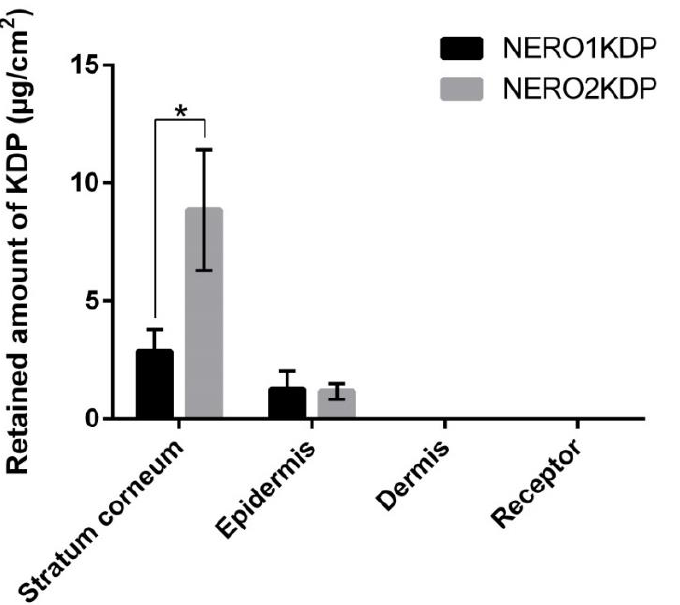
Figure 4. Kojic dipalmitate (KDP) concentrations in receptor medium, dermis, epidermis, and stratum corneum after treatment with 1 mg/mL (NERO1KDP) and 2 mg/mL (NERO2KDP) KDP-loaded nanoemulsions. An asterisk indicate significant differences between formulations for the same skin layer ( p ≤ 0.05).